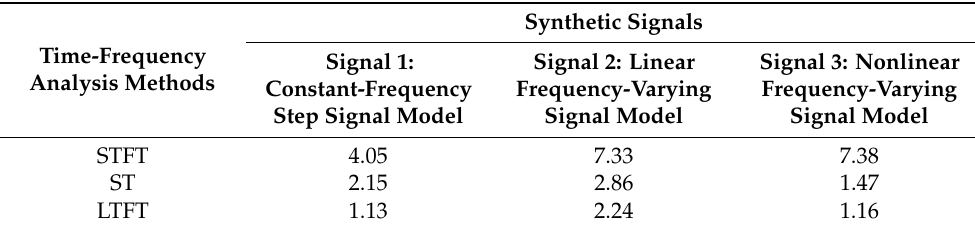
Table 1. R é nyi entropy of the synthetic signals’ time-frequency